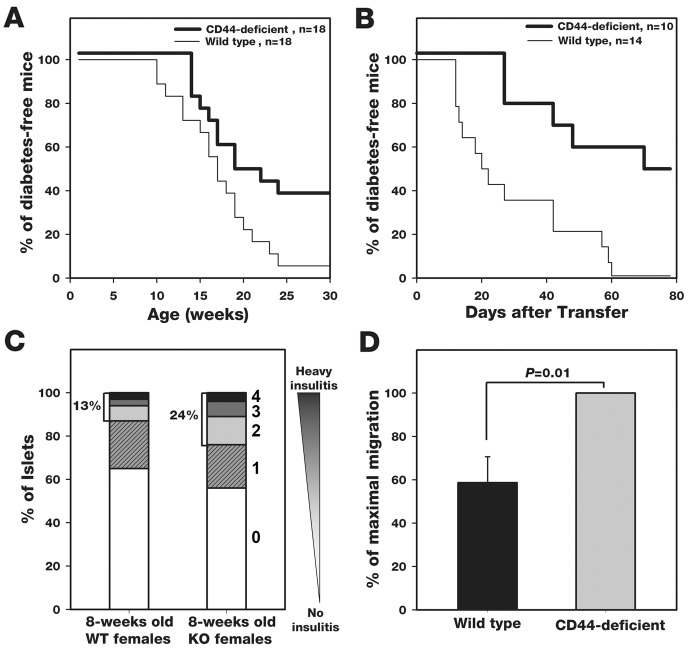
CD44-null NOD females display relative resistance to T1D: role of inflammatory cells.A) and B) Development of T1D in the spontaneous (A) and cell transfer (B) models of WT and CD44-deficient mice was monitored by measuring blood glucose. In the transfer model, irradiated CD44-deficient and WT young (6–8 weeks-old) male recipients were respectively transplanted with splenocytes from CD44-deficient and WT diabetic females. Percentage of diabetes-free mice (showing <250 mg/dL blood glucose) was recorded versus time. Statistical analysis by Breslow; A, P < 0.05; B, P < 0.005. C) The invasion capacity of infiltrating cells derived from WT (n = 6) and CD44-deficient (n = 6) NOD females (spontaneous model) was measured as indicated in Materials and Methods. A total of 754 pancreatic islets in each mouse group were scored by an uninformed observer. The percentage of islets showing each one of the infiltrating scores was calculated for each mouse, and the average values are presented. Islets from CD44-deficient mice display higher percentage of infiltrating scores (2, 3 and 4) than islets from wild type mice. P < 0.0001 by Pearson's χ2 test comparing the distribution of scores in the two mouse groups. D) Wild type or CD44-deficient pre-diabetic spleen cells were added to the top compartment of transwell migration chamber, separated by HA-coated filter (10 μg/filter) from the bottom compartment, and the % of cells migrating through the filter toward the chemoatractant in the bottom compartment was calculated by flow cytometry. Statistical analysis by Student’s-t- test. Accumulated data of 4 experiments (n = 8; error bars, SEM).